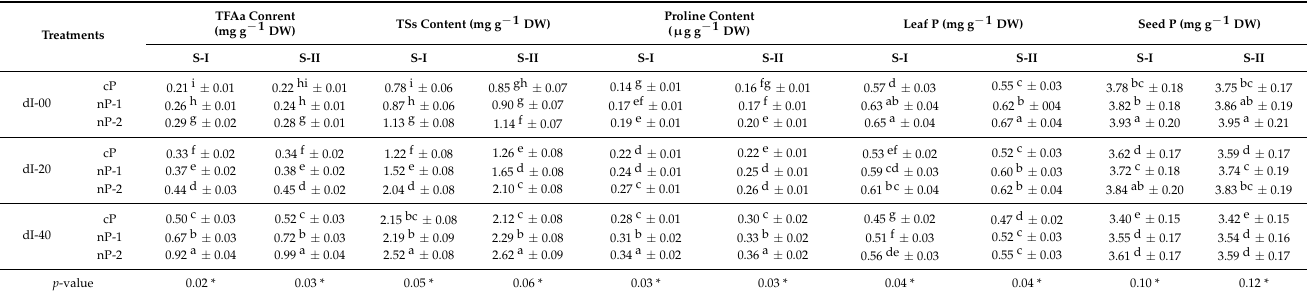
Table 6. Total free amino acids (TFAa), total soluble sugars (TSs), and free proline contents of fenugreek plants as affected by different irrigation water regimes and soil and foliar nourishing with phosphorus (P) during two growing